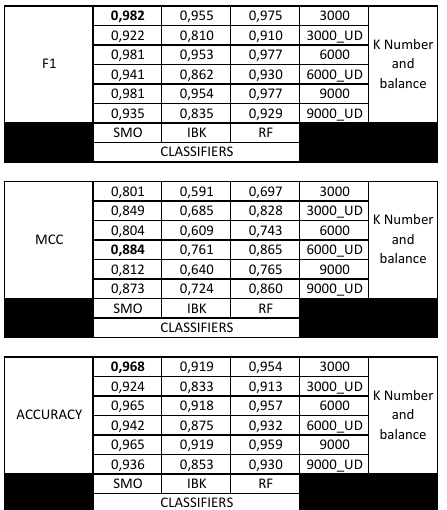
Figure 4. The confusion matrix generated by the classifiers with the different k configurations and balance. The colors illustrate the results of the classification process with blue being the highest results and red the lowest. The colors are separated by the k number.